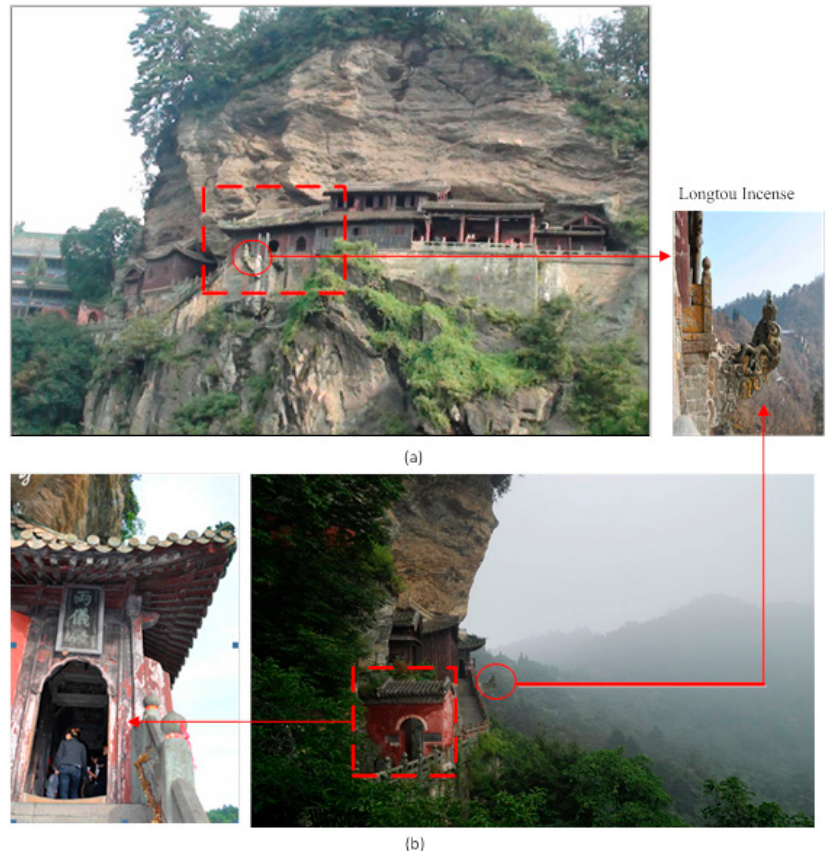
Figure 1. Ancient architecture of Liangyi Temple: ( a ) front side, ( b ) side face. The red dashed rectangle in ( a ) is the Liangyi Temple. The red dashed rectangle in ( b ) is the gate door of Liangyi Temple. The red circle is Longtou Incense.